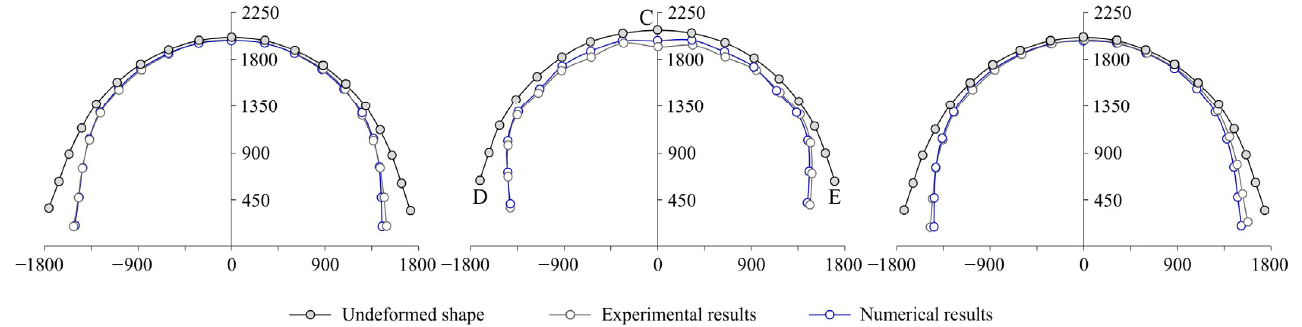
Figure 12. Experimental and numerical (model C5) deformation results of the three transverse laths of the TEL-gridshell (amplification factor =